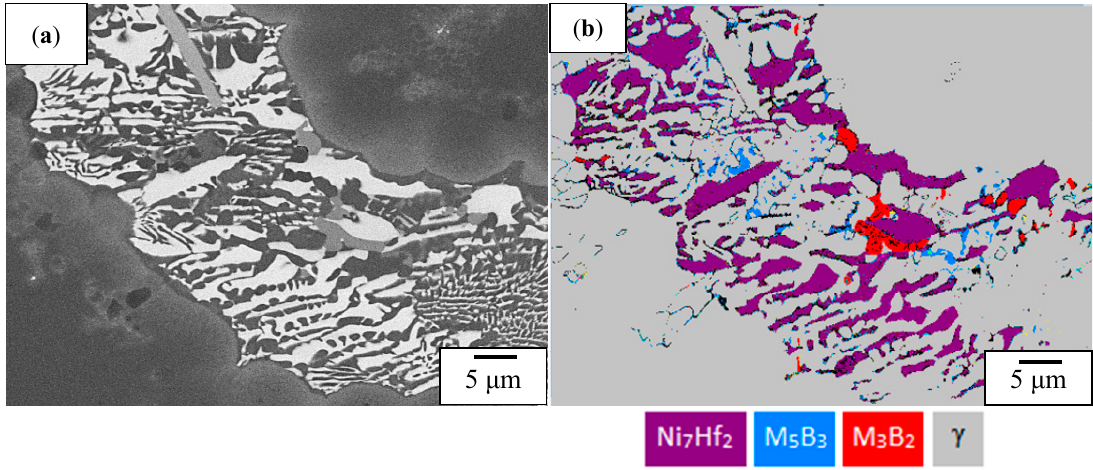
Figure 4. ( a ) BSE image of FESEM of the solidified products; ( b ) EBSD map to identify distinct phases.